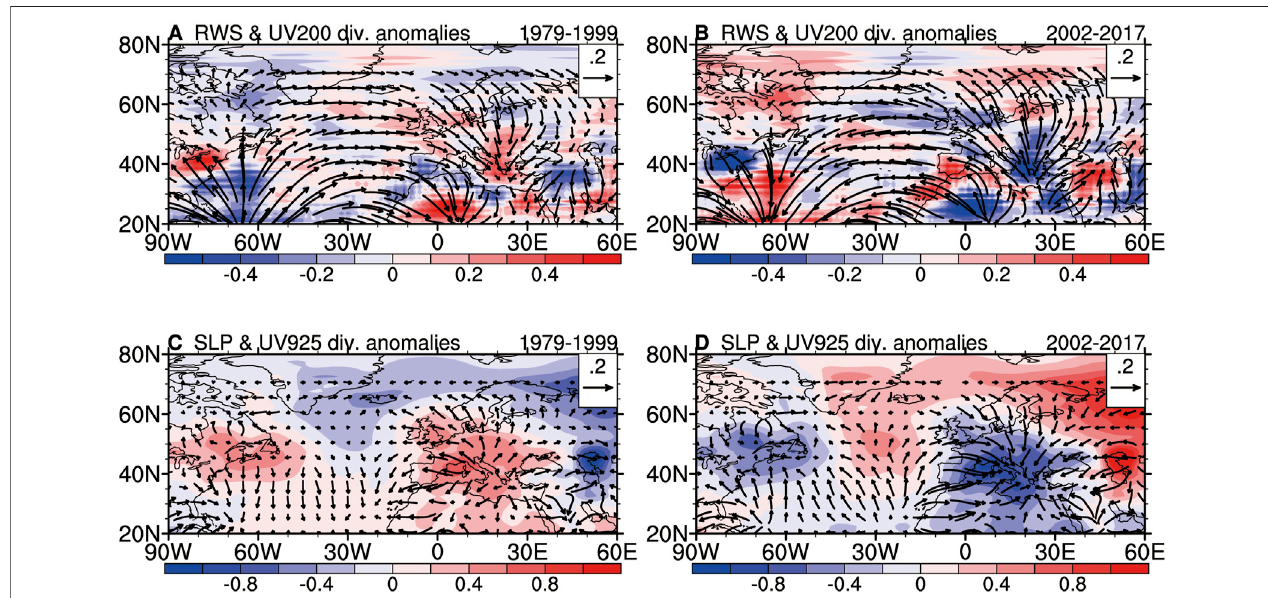
FIGURE8|(A,B) TheanomaliesoftheRossbywavesource(shading;units:10 – 10 s − 2 )anddivergentwind(vectors;units:m s − 1 )at200 hPaduring (A) 1979 – 1999 and (B) 2002 – 2017. Anomalies are calculated based on the climatology of 1979 – 2017. (C, D) As in (A, B) but for divergent wind (vectors; units: m s − 1 ) at 925 hPa and SLP anomalies (shading; units: